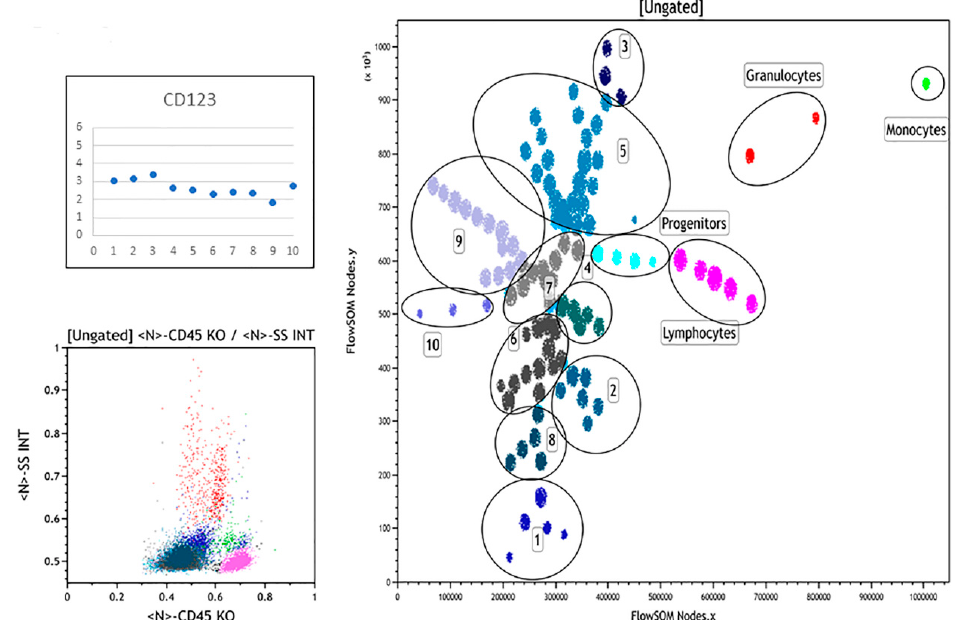
Figure 2. FlowSOM analysis of Case 1 (minimal spanning tree). CD123+ cells constitute a highly clustered population on a classical CD45/SSC scattergram (left lower panel), but FlowSOM (right panel) separates this population in an unsuspectedly large number of nodes that supervised node-by-node analysis cluster in 10 different populations (Supplementary Table S4). The upper left diagram shows the normalised MFI expression of CD123 in numbered cell subsets.